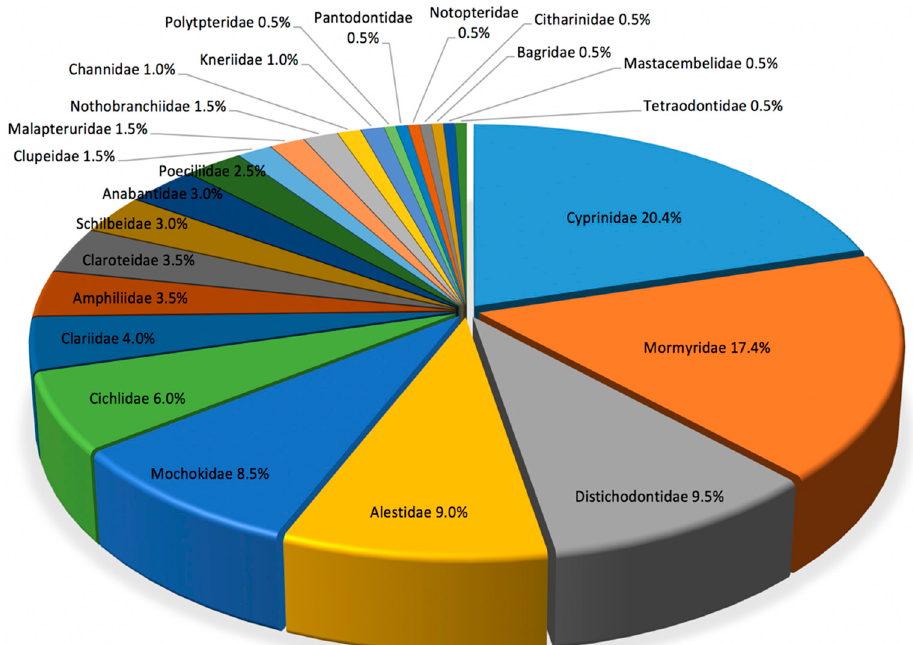
Figure 5. Relative representation of each family in the lower Lulua River.